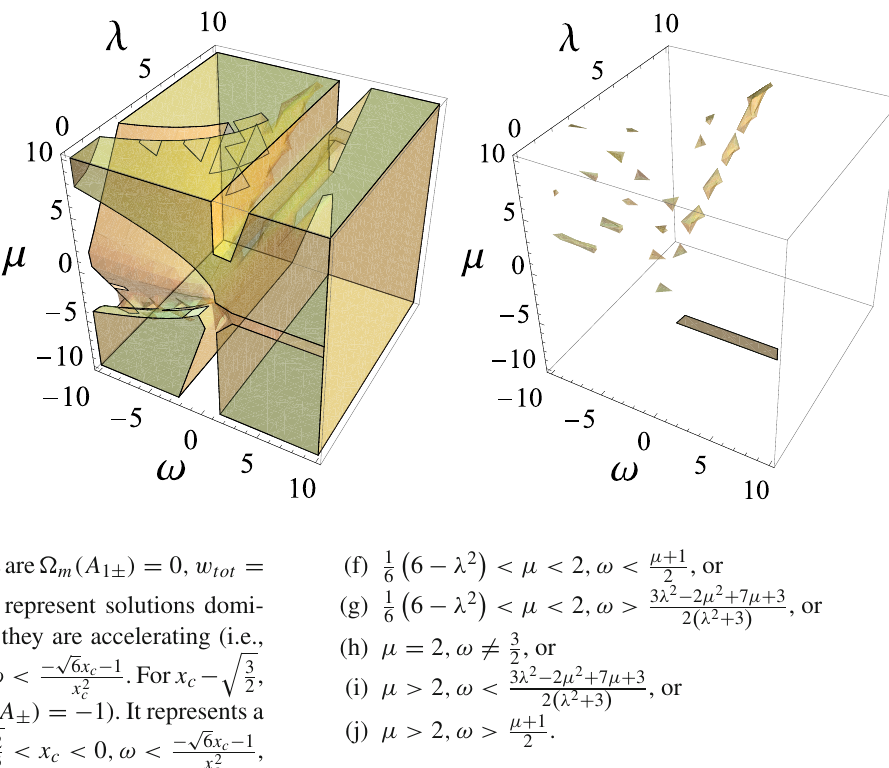
Fig. 13 Stability of A 3 when it is a sink (left panel) and when it is a source (right